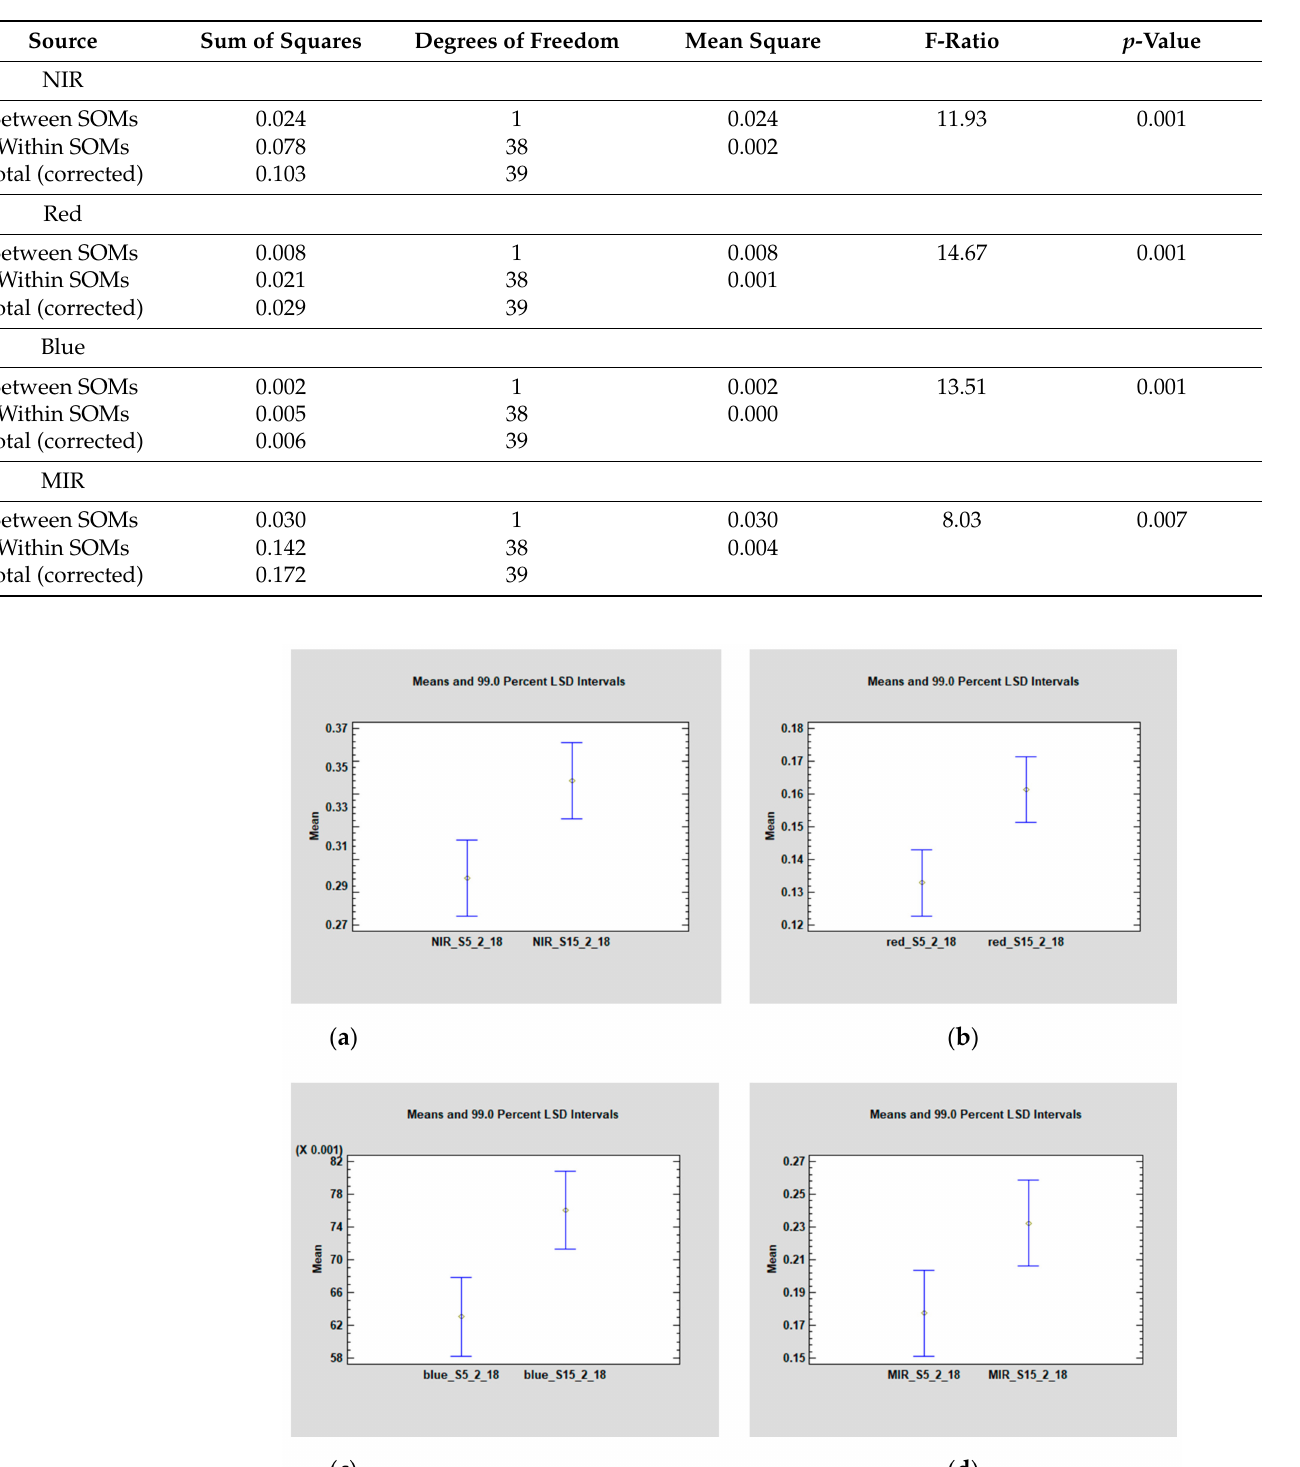
Table 4. Analysis of variance (ANOVA) showing significant statistical differences ( p -value < 0.01) for single bands (NIR, Red, Blue and MIR) for the two soil units SOM5 and SOM15.